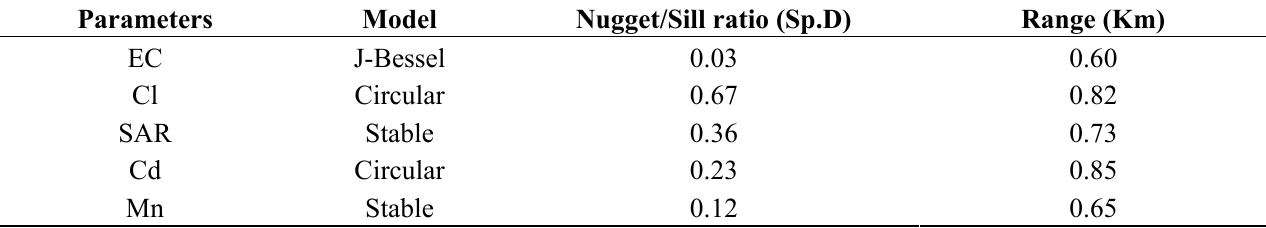
Table 10. Spatial dependency (Sp.D) and range of the interpolated models for different parameters.